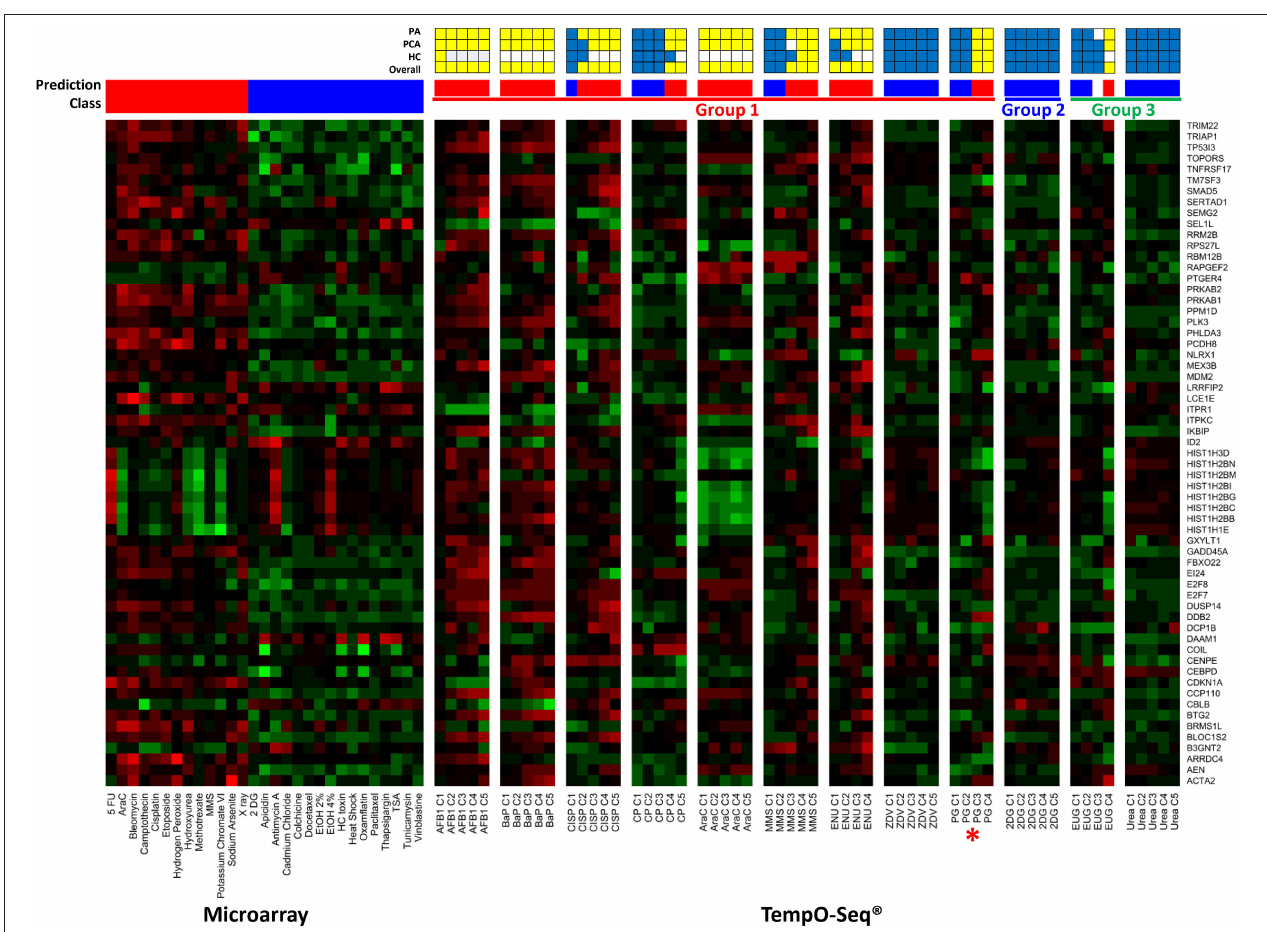
FIGURE 3 | TGx-DDI classification results are depicted using TempO-Seq ® gene expression technology for the 12 test chemicals. The heatmap on the left shows the gene expression responses of the TGx-DDI biomarker genes for the 28 reference compounds used to generate the biomarker using DNA microarray analysis in TK6 cells. The test chemicals assessed using TempO-Seq ® gene expression technology in human HepaRG TM cells are shown in the subsequent heatmaps (columns). Gene Symbols corresponding to the GenBank accession numbers for the TGx-DDI biomarker genes are shown on the right. The color scale specifies fold changes relative to control: up-regulated genes are red, down-regulated genes are green, and genes exhibiting no changes relative to controls are black. Overall calls for all treatment conditions are shown using red (DDI) and blue (non-DDI) bars above each heatmap. Chemical groupings from Kirkland et al. ( 57, 58) include Group 1 DDI chemicals (red), a Group 2 non-DDI chemical (blue), and Group 3 potentially misleading positive chemicals (green). DDI chemical abbreviations: aflatoxin B1 (AFB1), benzo[a]pyrene (BaP), cisplatin (CISP), cyclophosphamide (CP), cytosine arabinoside (AraC), methyl methanesulfonate (MMS), N-ethyl-N-nitrosourea (ENU), zidovudine (ZVD), and propyl gallate (PG; *included with Group 1 chemicals). Non-DDI chemical abbreviations: 2-deoxy-D-glucose (2DG), eugenol (EUG), and Urea. The grids above the heatmaps indicate the results of the three different TGx-DDI analyses: Probability Analysis (PA, based on nearest shrunken centroid analysis), Principal Component Analysis (PCA) and Hierarchical Clustering (HC). The overall call is DDI if any one of these analyses yields a DDI call. Yellow boxes indicate a positive DDI classification, blue denotes a negative non-DDI classification and white signifies an unclassified response (i.e., does not yield a DDI or non-DDI call).